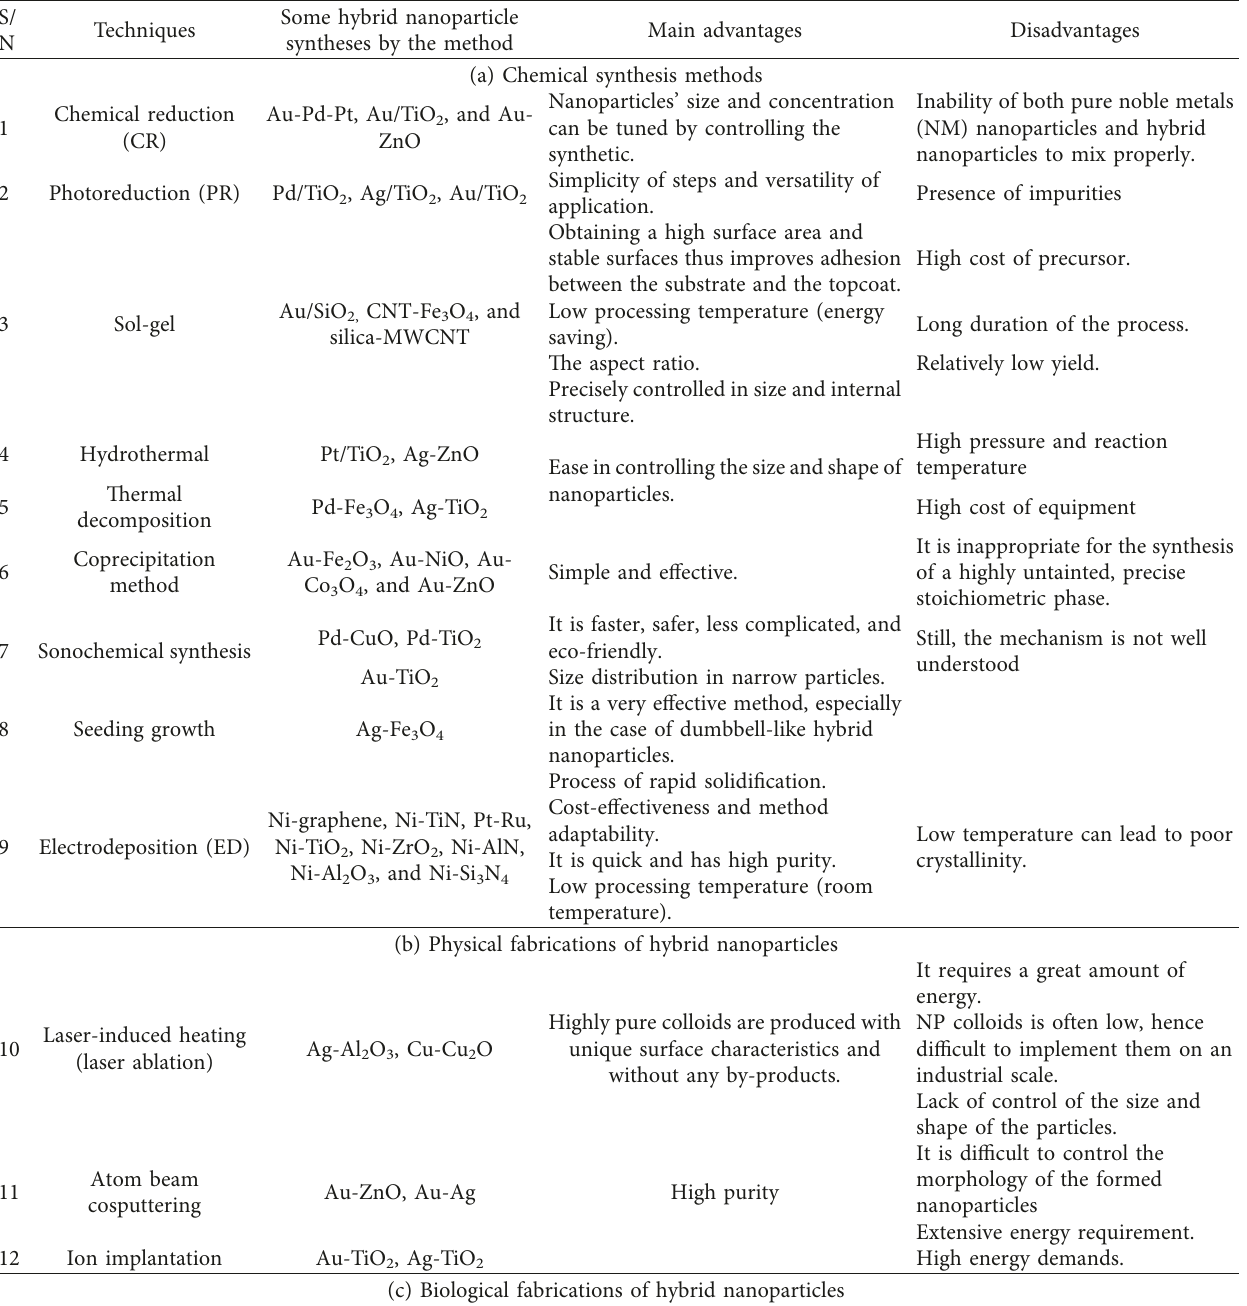
Table 2: Summary of the method of preparation of hybrid